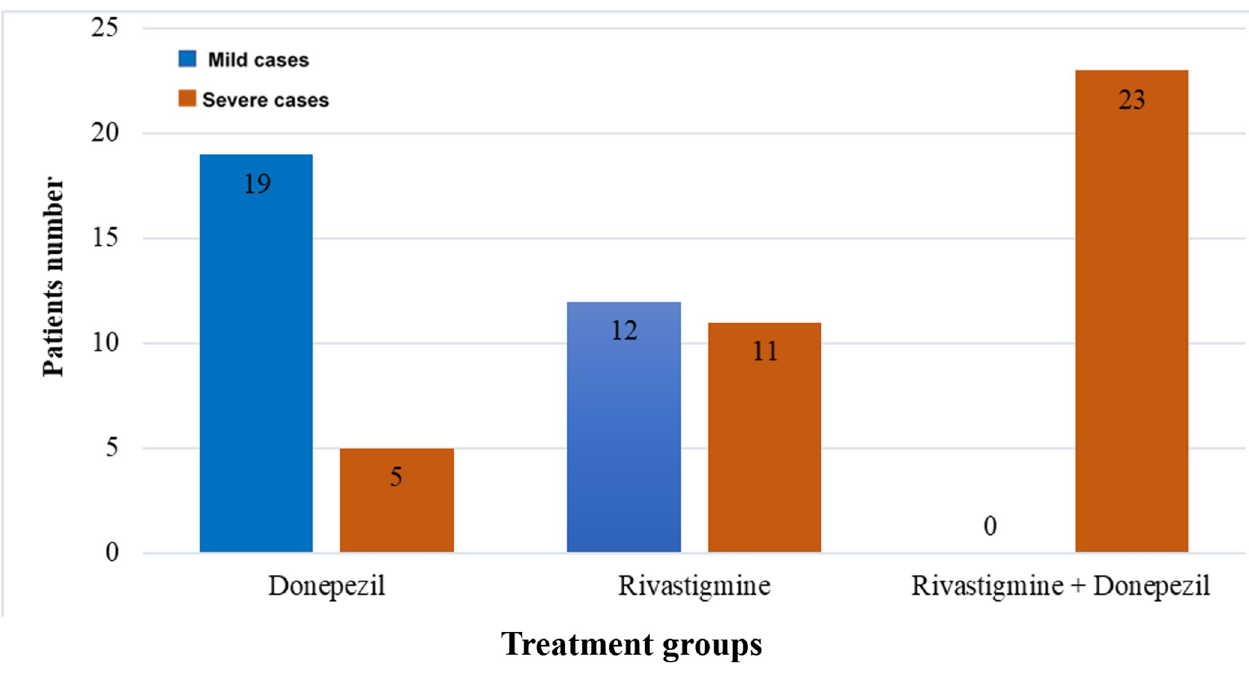
Fig 3. Descriptive data for the treated Alzheimer